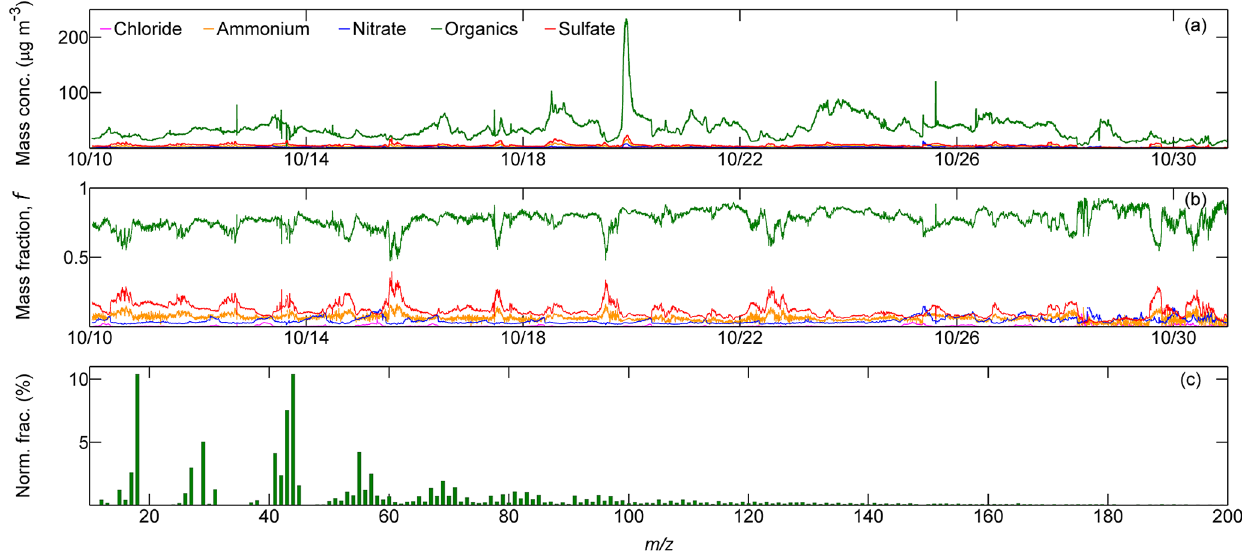
Figure 3. Time series of (a) mass concentration (“Mass conc.”, µgm − 3 ) and (b) corresponding mass fraction, f , of the five specific chemical species in NR-PM 1 measured by ToF-ACSM (abscissa shows the observation dates in October 2015 in the date format of monthday − 1 ). (c) Temporally averaged OA mass spectra for submicron wildfire haze particles, displayed with the normalized ion fraction (Norm. frac., %) of each ion fragment. Wildfire haze particles were predominantly composed of organics. Ion signals ( m/z ) from oxygenated organics (e.g., m/z 43, 44) were prominent, while intensities of ions for hydrocarbon-like organic compounds (e.g., m/z 41, 55, 57) and biomass burning tracers (e.g., m/z 60, 73) were relatively less intense. See the text for details.